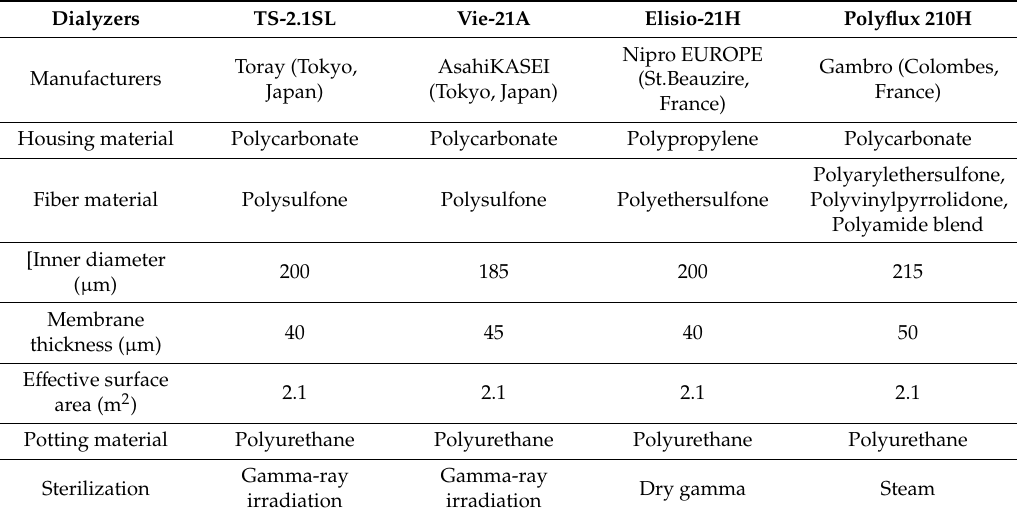
Table 1. Hemodiafiltration dialyzers